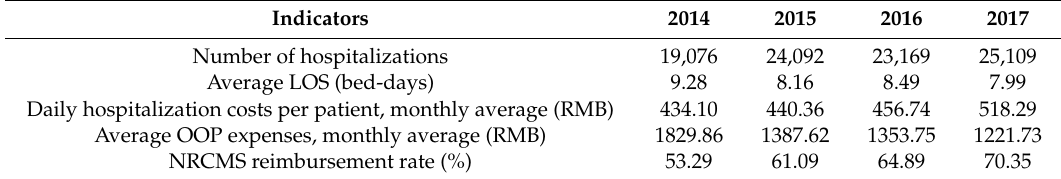
Table 2. Outcomes of the elderly in primary health institutions during study period in Qidong County, Jiangsu Province, 2014 to November 2017.